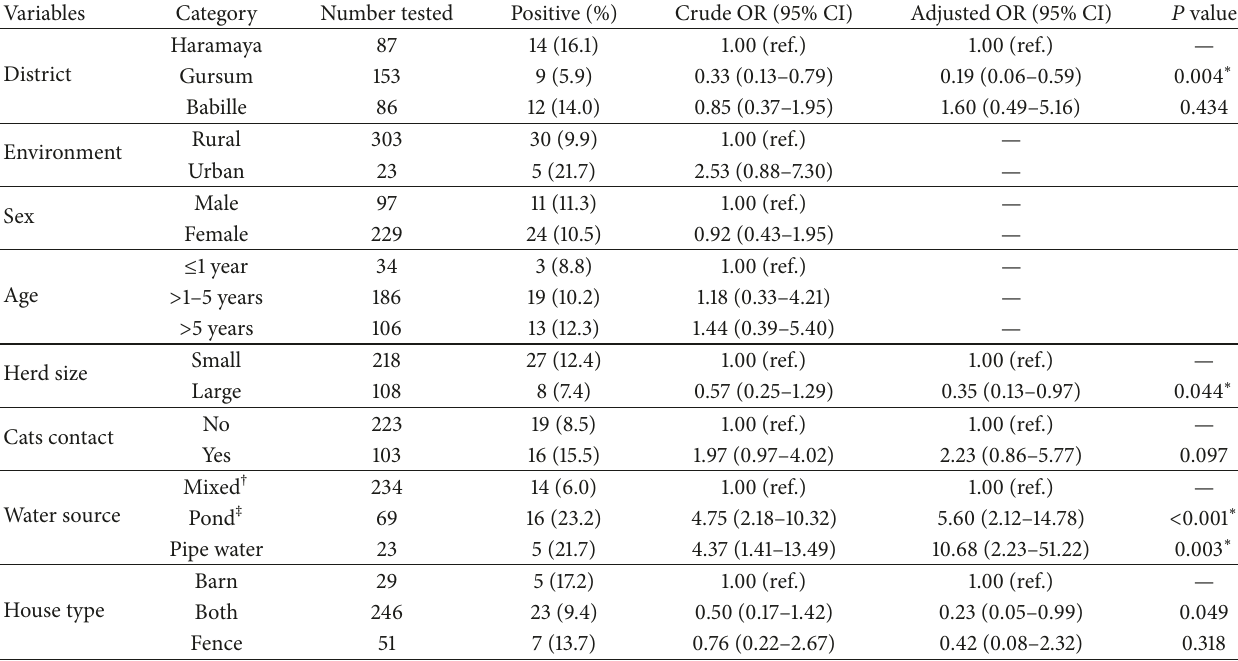
Table 4: Logistic regression analysis of risk factors with T. gondii seropositivity in cattle at animal level ( 𝑛 = 326 ). Variables